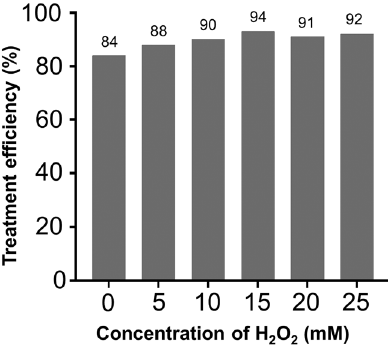
Figure 3: E ff ect of H 2 O 2 concentration on the DBF degradation e ffi - ciency. [ DBF ] = 30 ppm, catalyst dosage = 10 mg, room temperature, time = 60